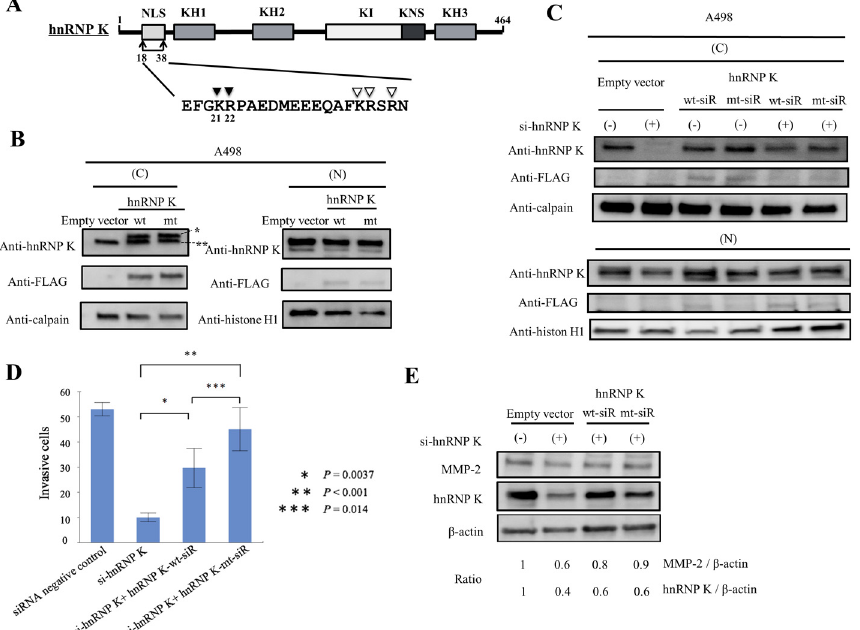
Fig 6. Functional analysis of exogenous hnRNP K mutants in RCC cells with down-regulated endogenous hnRNP K. A. Mapping of structural domains of hnRNP K protein. The locations of the nuclear localization signal (NLS), K homologue (KH), K-protein-interactive (KI) and nuclear shuttling (KNS) domains are indicated (upper panel). A putative consensus sequence of the bipartite NLS is defined as (K/R)(K/R) X10-12(K/R)3/5, where X indicates any amino acid and (K/R)3/5 represents at least three of either lysine or arginine out of five sequential amino acids. Arrowheads indicate the conserved amino acid residues in NLS (lower panel); B. Exogenous expression of hnRNP K wild type (wt) or mutant (mt; K21A and R22A) is dominant in the cytoplasm. Single asterisk ( * ) and double asterisks ( ** ) indicate FLAG-hnRNP K and endogenous hnRNP K, respectively in the left and upper panel. Signals against FLAG-tag are indicated as exogenous expression of hnRNP K; C. Expression of hnRNP K constructs was measured by western blotting with anti-hnRNP K antibody in A498 cells treated with control siRNA or si-hnRNP K. As indicated in the column, these cells were co-transfected with control empty vector, si-hnRNP K resistant wild-type hnRNP K (hnRNP K-wt-siR) or si-hnRNP K resistant mutant hnRNP K (hnRNP K-mt-siR). Anti-calpain antibody or anti- histone H1 antibody was used as loading control for the cytoplasmic or nuclear fraction, respectively; D. Exogenous expression of hnRNP K-wt-siR or hnRNP K-mt-siR significantly suppressed the inhibition of cell invasion by endogenous hnRNP K knock-down in A498 cells. Three individual experiments were performed, and mean ± s.d. is presented; * P , ** P , *** P < 0.05 compared with the second lane treated with si-hnRNP K (Student ’ s t -test, n = 3); E. Exogenous expression of hnRNP K-wt-siR or hnRNP K-mt-siR reversed the down- regulation of MMP-2 expression induced by endogenous hnRNP K knock-down. Anti- β -actin antibody was used as an indicator of the loaded volume of total cell